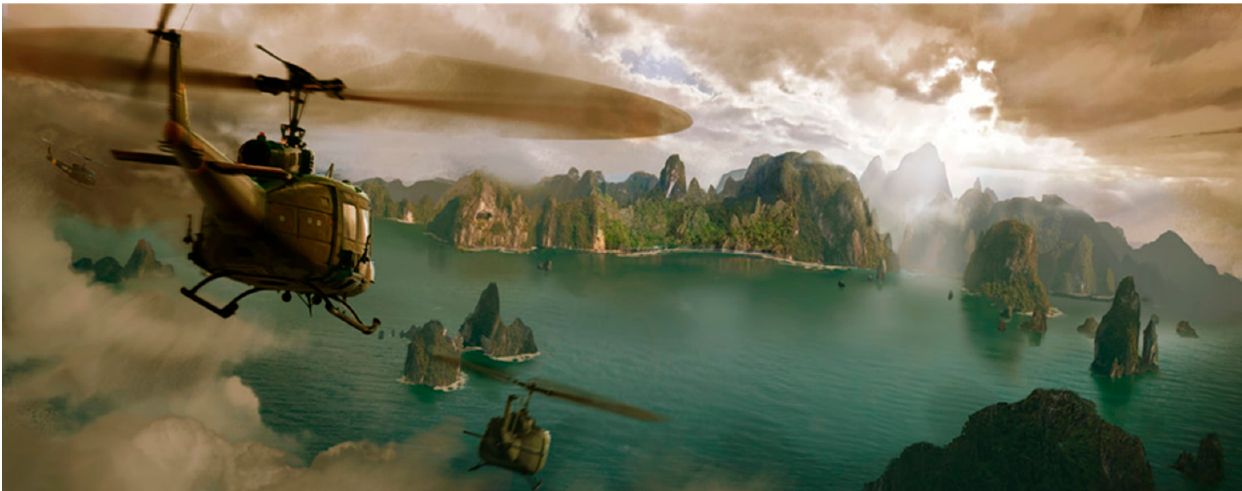
Figure 7. Labyrinthine landscape of Skull Island (2017). https://www.kaijubattle.net/saturday-showcase/saturday-show- case-kong-skull-island-concept-art-by-zachary-berger (accessed on 1 January 2021).